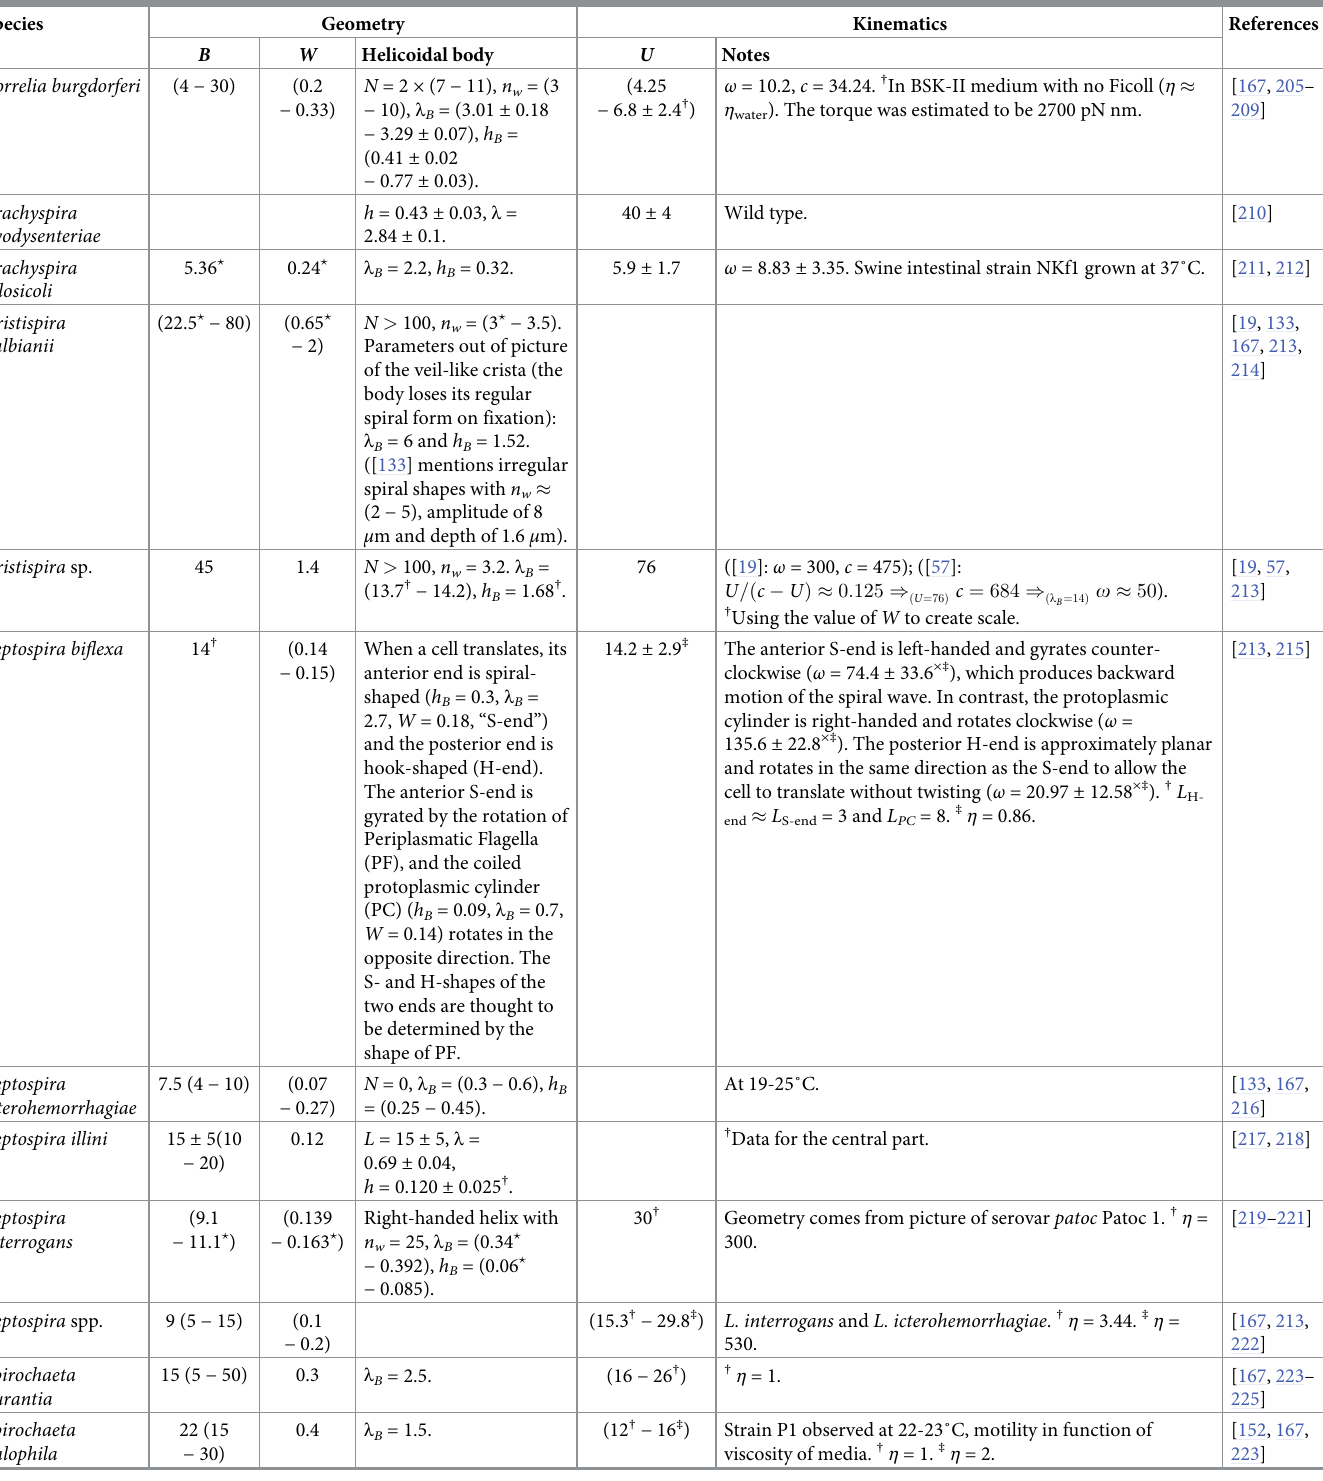
Table 5. Data for swimming Spirochaetes and Spiroplasma . Species